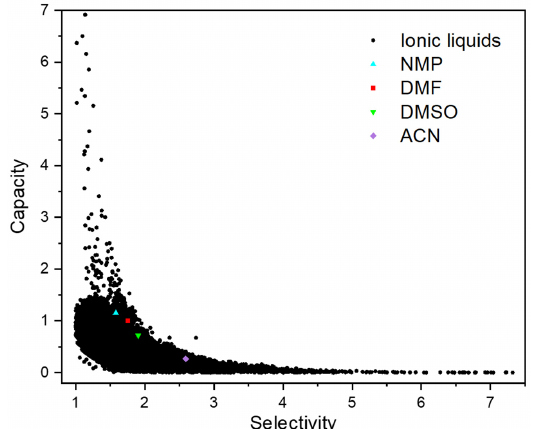
Figure 1. Infinite dilution capacity and selectivity of ILs and reference solvents calculated by COSMO-RS at 298.15 K. The capacity and selectivity of NMP, DMF, DMSO and ACN are also depicted in Figure 1. Obviously, many ILs have larger capacity and selectivity than these four organic solvents. A boundary front was regressed based on the four solvents to explicitly screen ILs. As shown in Figure 2, two empirical selection criteria were defined to exclude the ILs with moderate performance. The first was that the capacity difference between the prom- ising ILs and the boundary front should be larger than 0.1. The second was that the selec- tivity of ILs should be between those of NMP and ACN. Accordingly, as listed in Table S3 (Supplementary Materials), 190 out of 36,180 ILs met the two thermodynamic criteria and thus were retained. Figure 2. Screening of ILs with better extraction performance in contrast with the reference solvents (capacity of IL > capacity of organic solvents + 0.1).